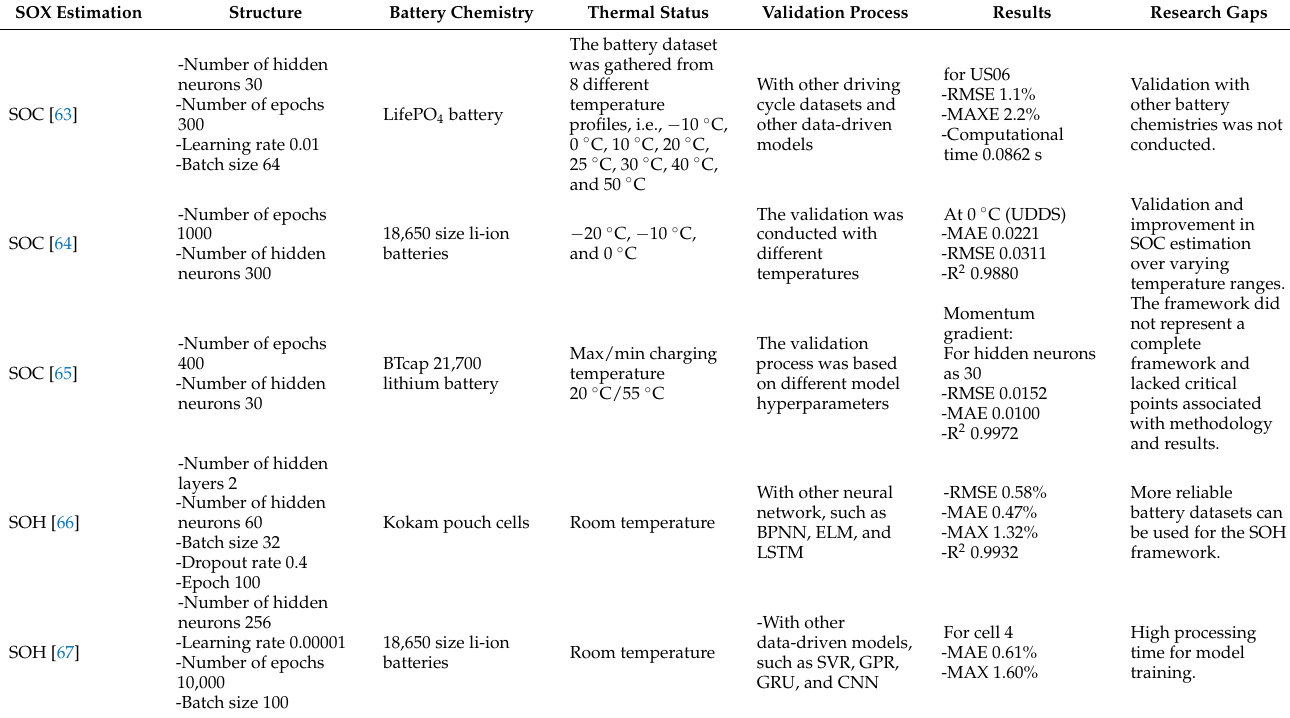
Table 4. Summary of GRU-based SOX estimation